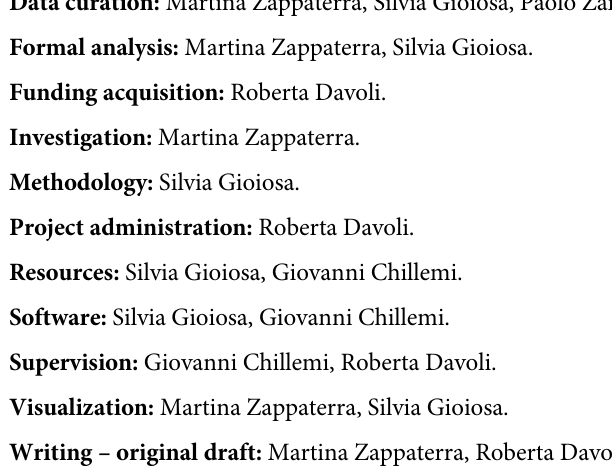
S3 Table. The list of the genes found differentially expressed (DE) with q value � 0.10. S4 Table. ClueGO Gene Ontology (GO) results of the genes in the four significant modules obtained from